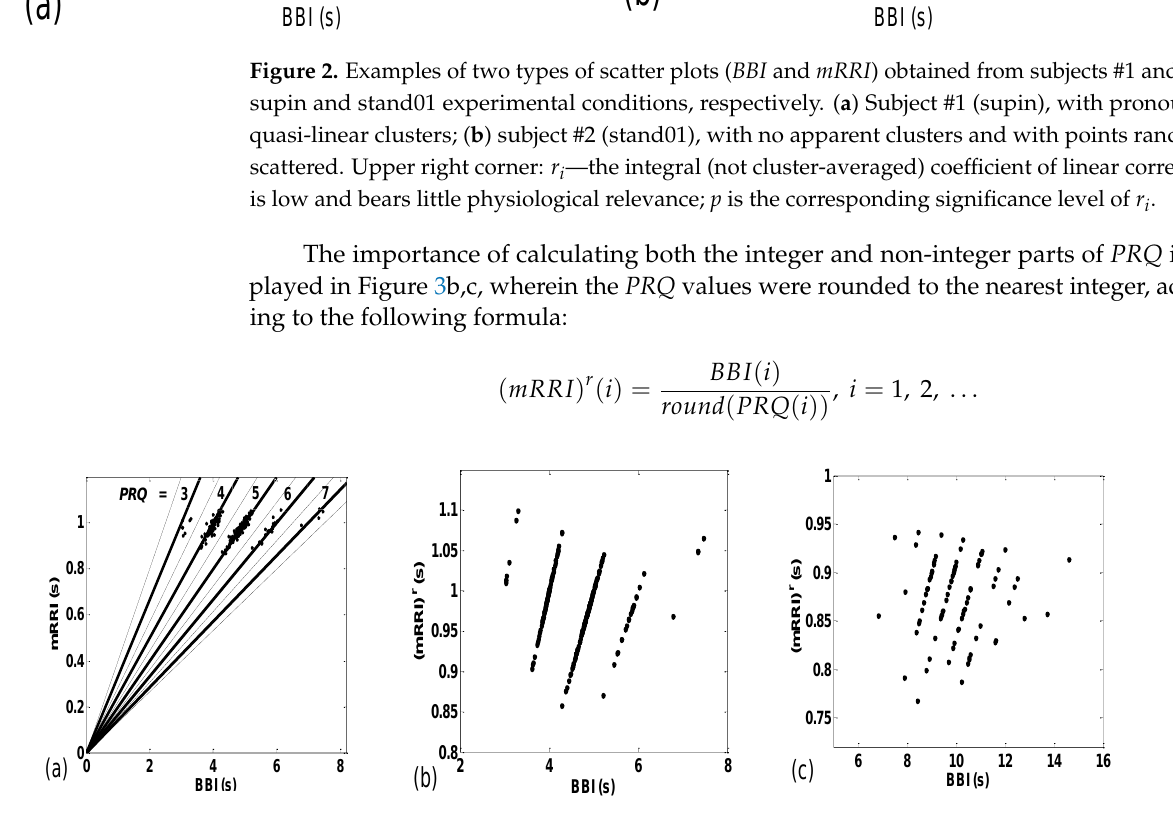
Figure 3. ( a ) The same data as seen in Figure 2a, with concurrent PRQ int lines added. Solid lines represent PRQ int ; dashed lines are used for PRQ int ± 0.5, representing the cluster borders; ( b , c ) shows the same data as in Figure 2a,b, respectively, drawn with ( mRRI ) r , referring only to integer parts of PRQ values, according to Equation (3), and showing that all scattering information is thereby lost.